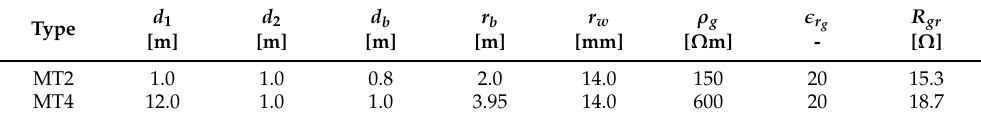
Figure 19. Grounding system impedance (magnitude and argument). ( a ) Magnitude. ( b ) Argument. Table 7. Geometrical parameters and soil properties required for the characterization of the grounding systems under